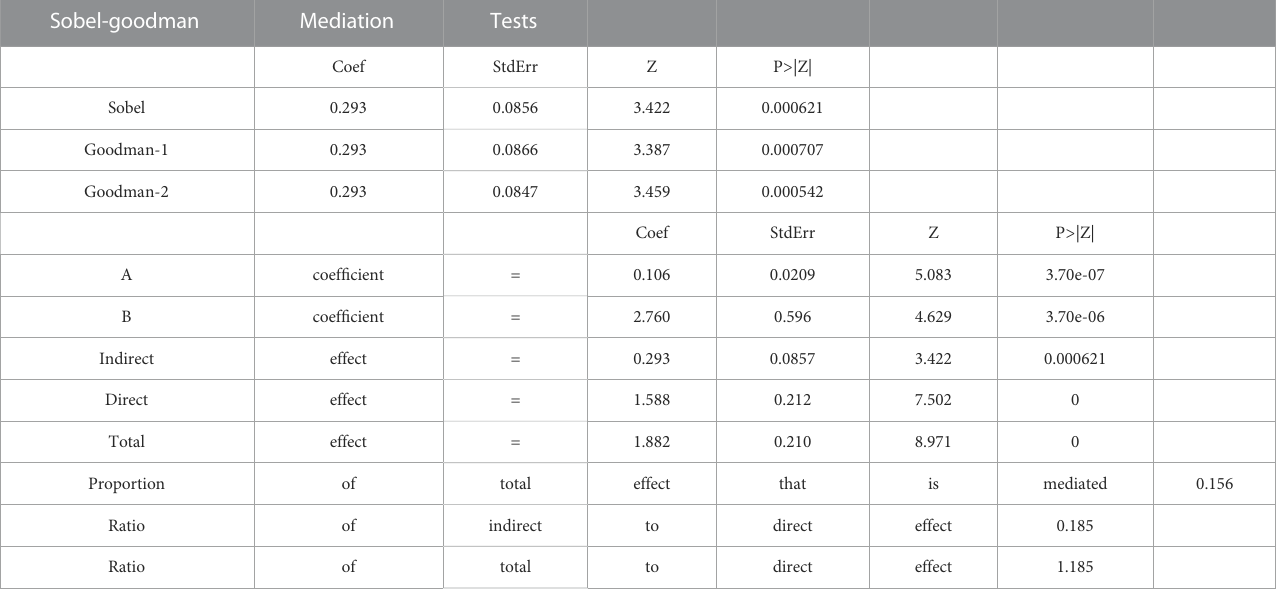
TABLE 5 Sobel-Goodman test results.